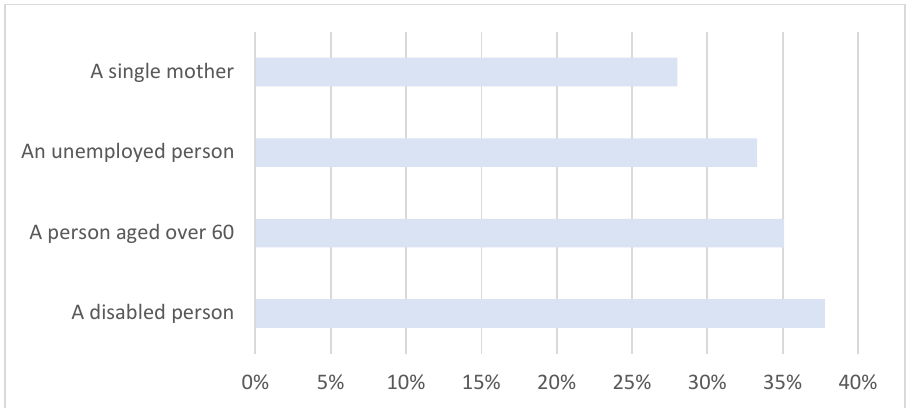
Figure 5. The awareness of respondents about PLC technology allowing them to use a power line at home or in an apartment for internet access ( n = 521) (source, own research).